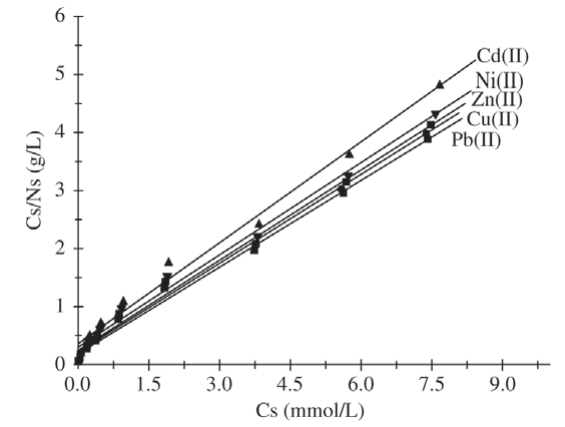
Figure 5. Linearization of adsorption isotherms of Cd(II), Cu(II), Ni(II), Pb(II) and Zn(II) in aqueous solution on Cell-PAB surface at room